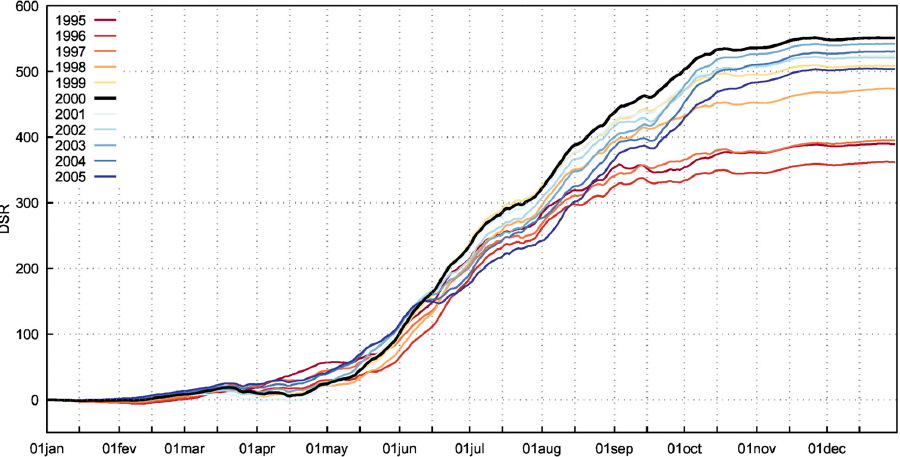
Figure 8. Sensitivity analysis of the DSR difference curve (Figure 7b) by changing the partition year of the study period with a forward and backward shift of a maximum of 5 years. The black curve (labeled in the graph as 2000) shows that the maximum difference in the mean cumulative DSR by the end of the year is obtained when dividing the study period into 1980–1999 and 2000–2018. The DSR is cumulated daily from 1 January to 31 December each year.